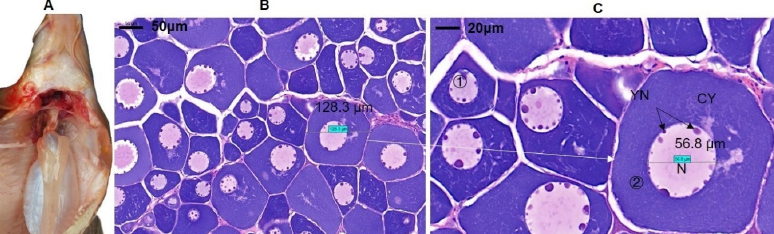
Figure 1. Development of ovaries in C. guichenoti. ( A ) Gonad appearance; ( B , C ) are microscopic characteristics of ovarian slices. ① Primary growth oocytes; ② large oocyte; YN: yolk nucleus; N: nucleoli; CY: cytoplasm.